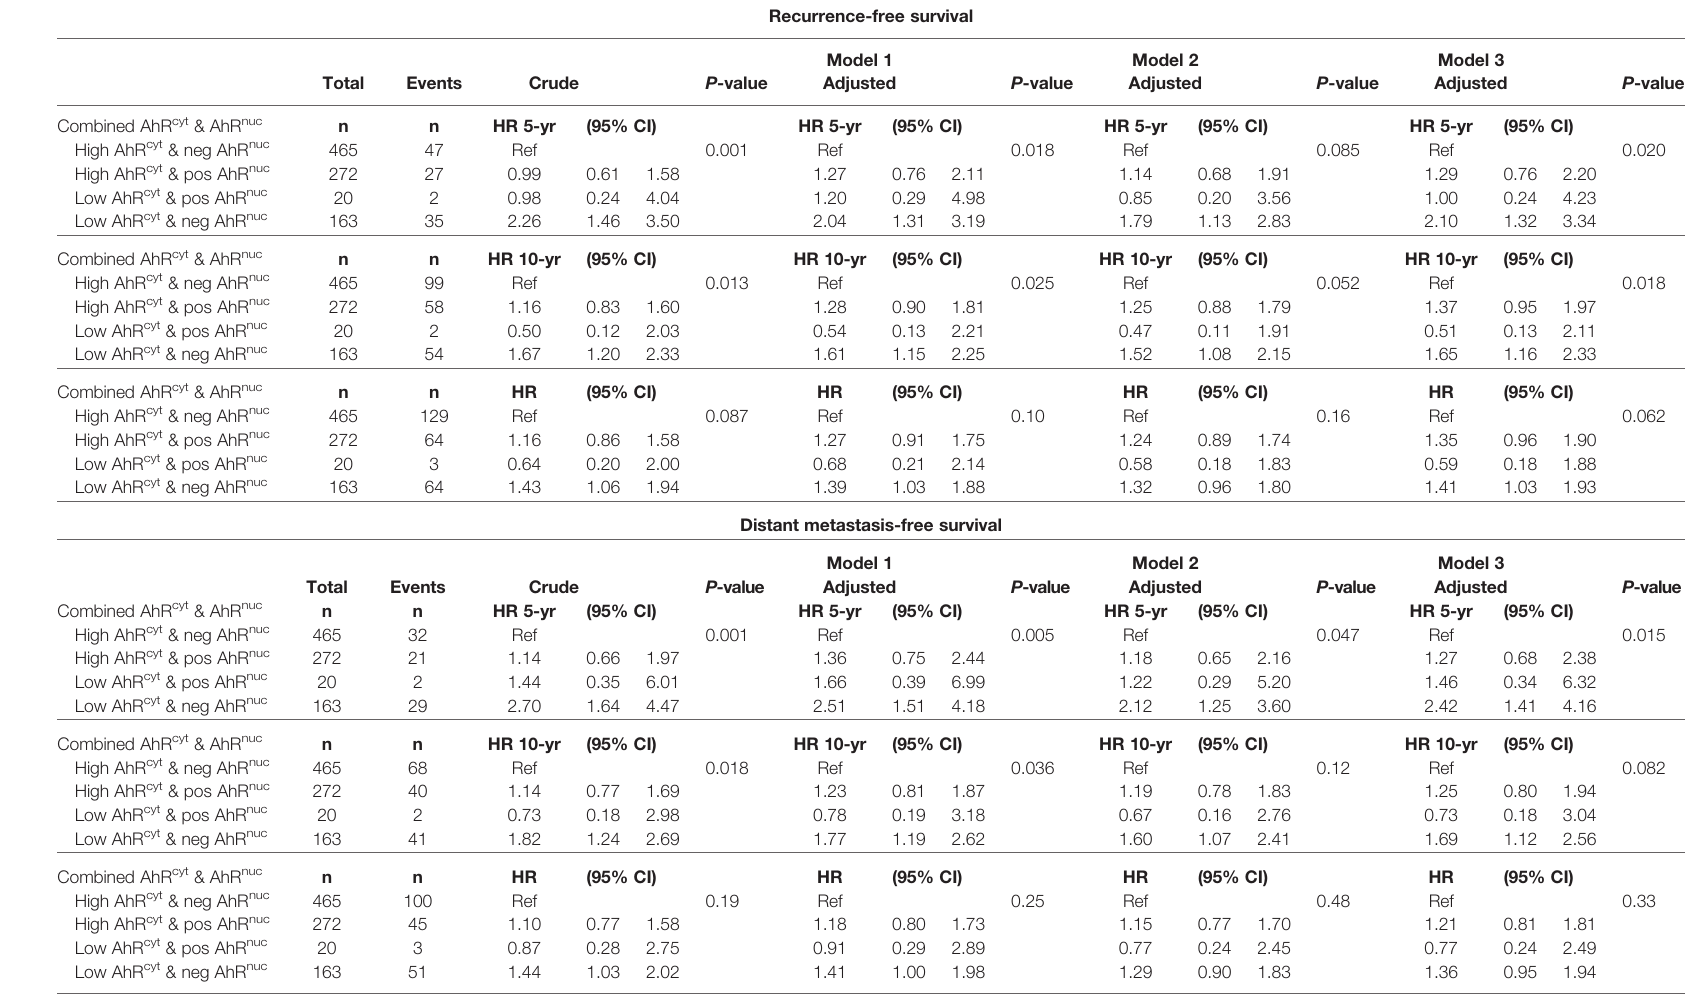
Model 1: Time between surgery and staining Model 2: Adjusted for model 1 + age, BMI ≥ 25 kg/m 2 , tumor size, node status, grade III, ER status. Missing data for 30 patients for at least one variable. Model 3: Adjusted for model 1+2 + preoperative smoking, alkohol abstention and adjuvant treatments. Missing data for 34 patients for at least one